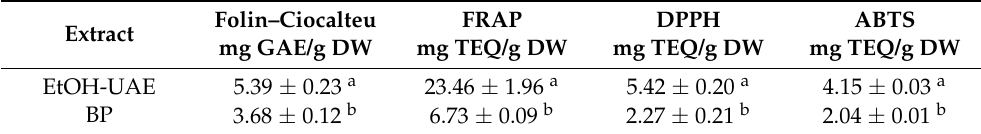
Table 2. Antioxidant capacity of the two